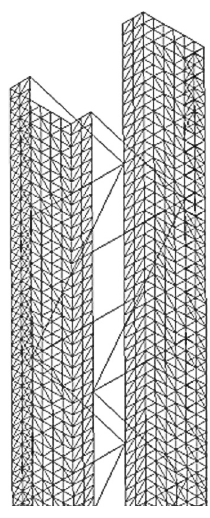
Fig. 4. Fragment of the column FEM model